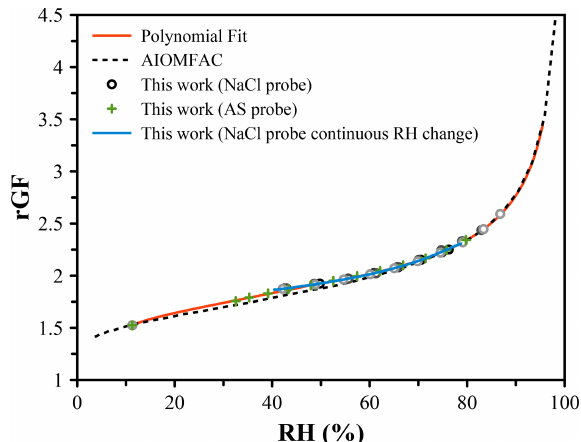
Figure 3. Hygroscopic growth of lithium chloride determined us- ing an NaCl droplet as a probe of the RH (black points) and an ammonium sulfate droplet (green points). A continuous RH change measured using an NaCl droplet is shown in blue. The radial growth factor at the deliquescence RH is set at 1.525. The AIOMFAC pre- diction agrees well at high RH ( > 70%). A polynomial fit (Table 2) was derived to translate measured radial GF of LiCl to the RH for use as a probe under low-RH conditions; shown in